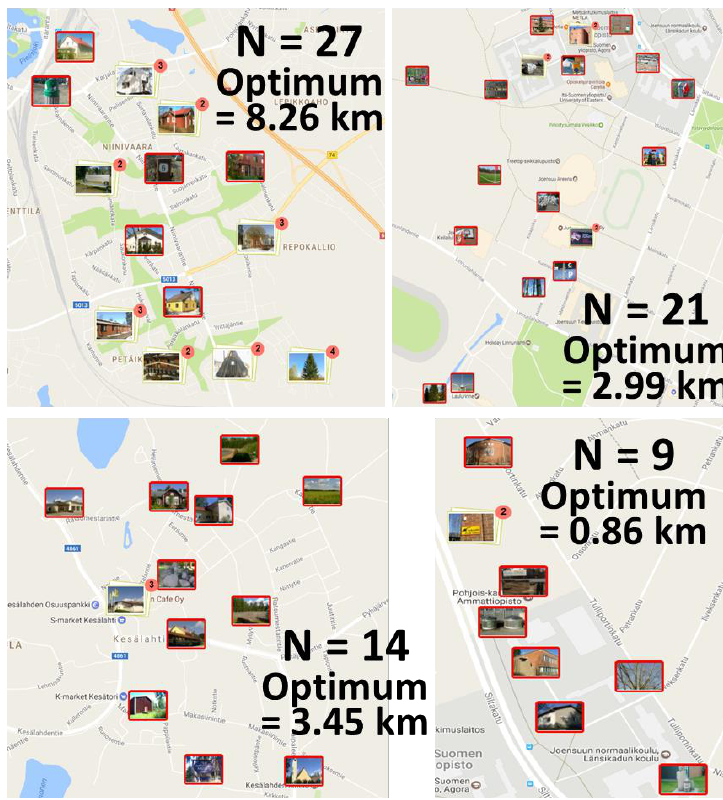
Figure 22. Productivity of the operators during the search with for 4 different O – Mopsi instances.